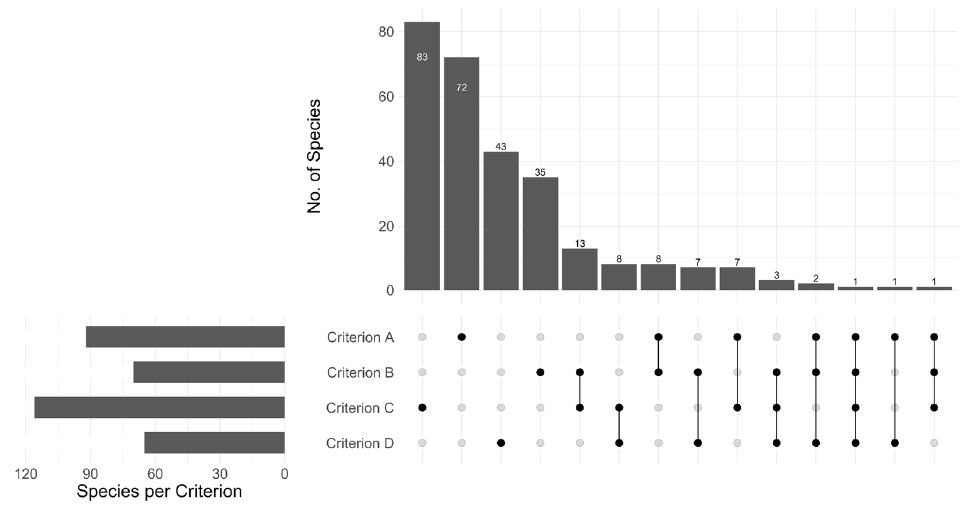
Figure 4. Criteria used in global assessments of threatened fungi in the Red List (n = 284) showing the frequency with which individual criterion (dots) and combinations of criteria (dots joined by vertical lines) were utilized. Criterion A is related to population size reduction, criterion B to restricted geographic range, criterion C to small population size and decline, and criterion D to very small or restricted population and distribution range.